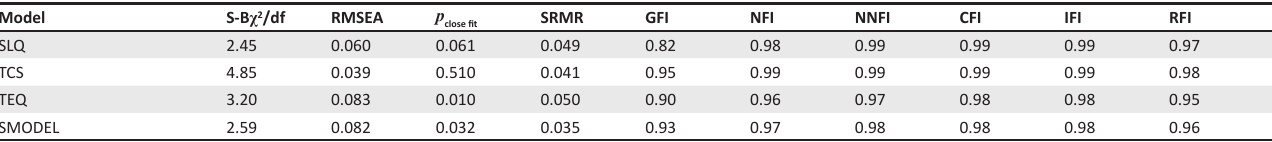
TABLE 1: Goodness-of-fit indices obtained for the refined servant leadership questionnaire, affective team commitment survey and team effectiveness questionnaire measurement and structural models. Model